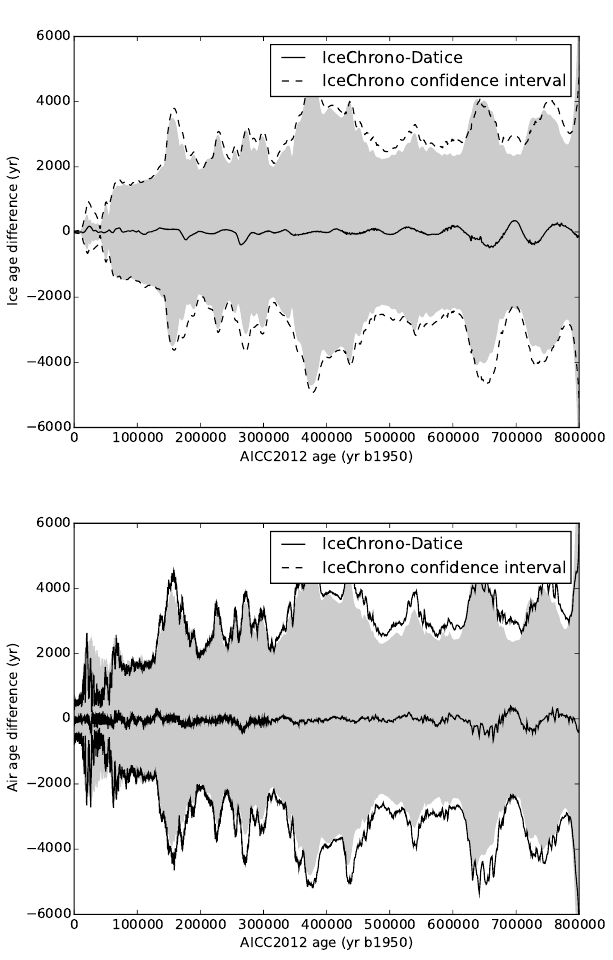
Figure 5. Comparison of IceChrono and Datice chronologies of the EDC ice core in the AICC2012 experiment, for the last 60kyr. IceChrono is the black plain line and its standard deviation is the black dashed line. The AICC2012 standard deviation is represented by the grey area. (top) Ice chronologies. (bottom) Air chronologies.